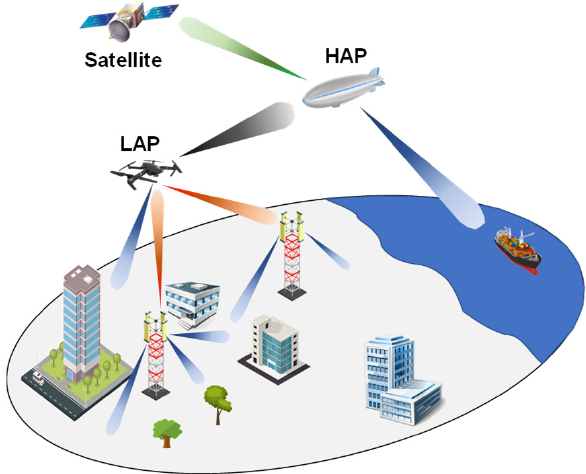
Figure 4. Example of hybrid network topology by involving terrestrial, airborne and satellite segment.